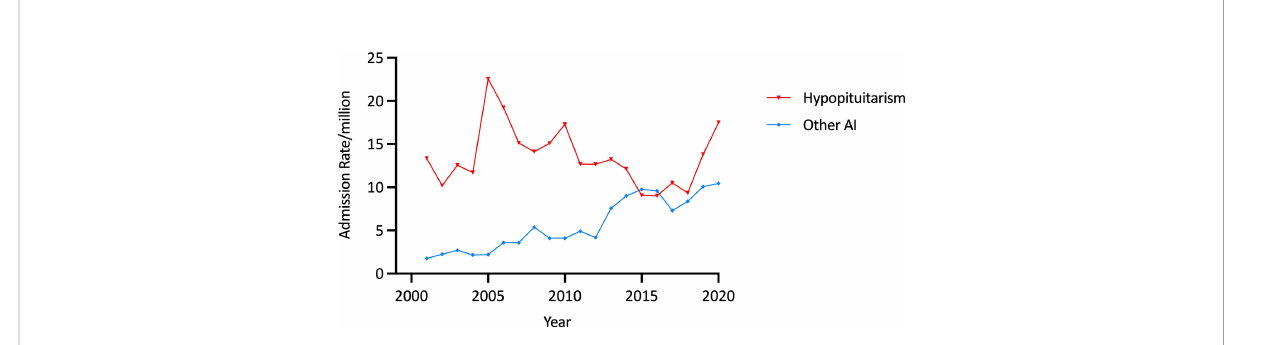
FIGURE 8 Age-adjusted admission rates for “ Other AI ” and hypopituitarism, 10-24 years, Australia, 2000/1 to